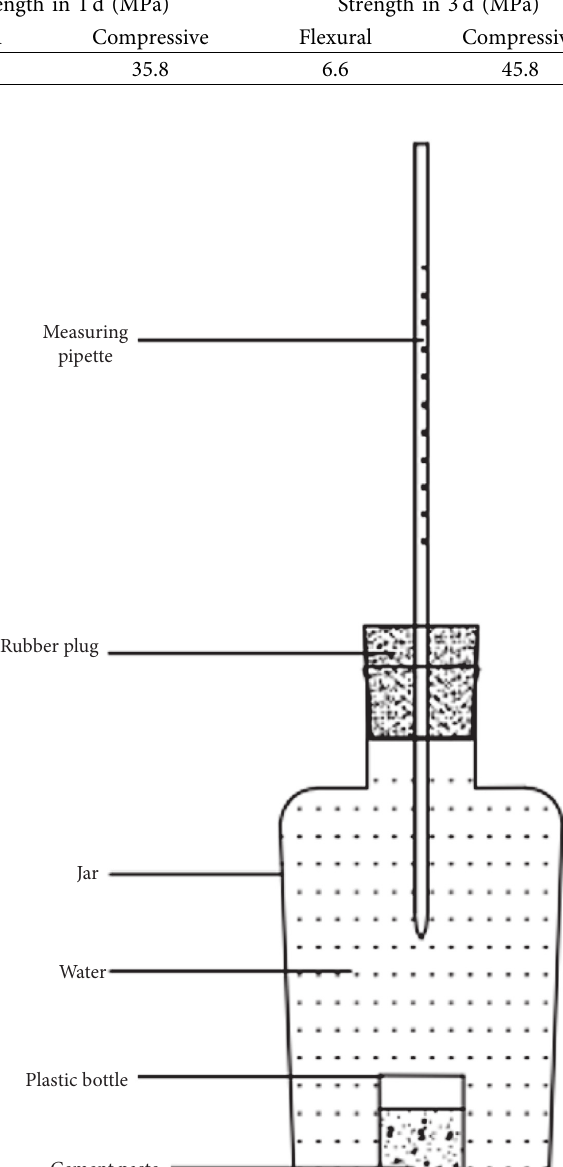
Figure 2: Chemical shrinkage